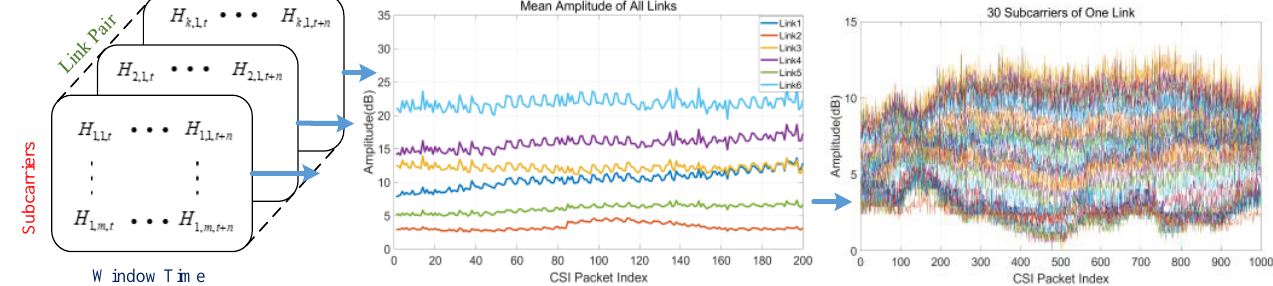
Figure 2. Description of amplitude fluctuation of six multi-input multi-output (MIMO) link pairs and 30 subcarriers based on 3-dimensional mathematical model.